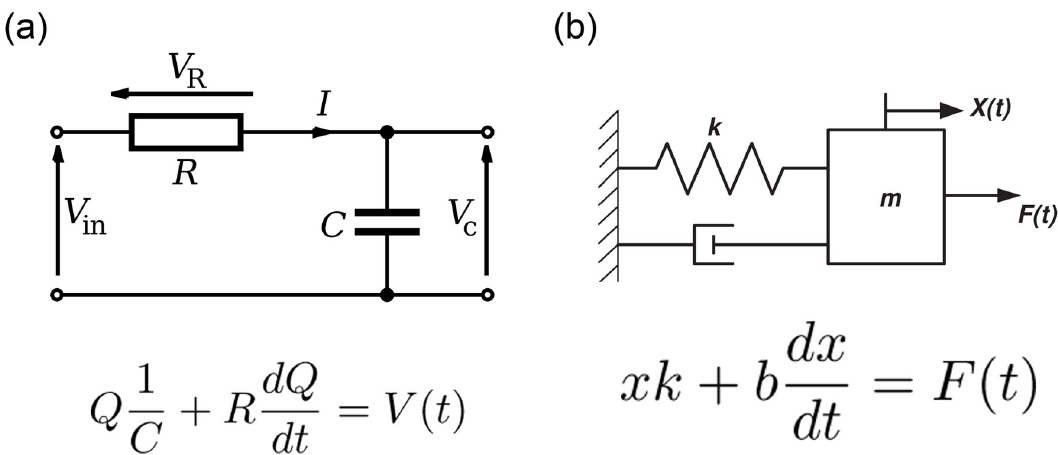
Fig 6. Equivalence between (a) RC model and (b) Mechanical model. The electric charge ( Q ) and current ( dQ / dt ) are equivalent to the position ( x ) and velocity ( dx / dt ) respectively. By inspection, k � 1/ C and b � R . In hydraulics terms, flow rate _ V flow volume V � x L i